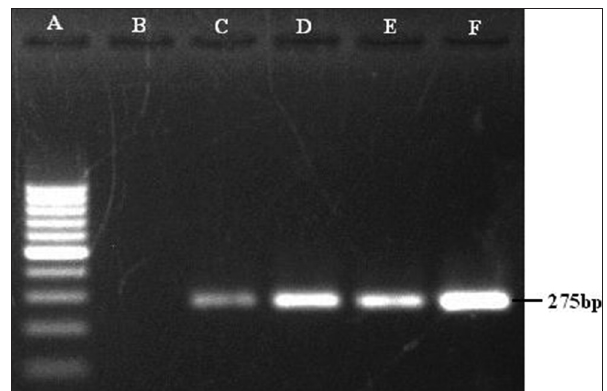
Figure-7: Polymerase chain reaction for the detection of pfhA gene (275 bp) of Pasteurella multocida. Lane A: 100 bp DNA Ladder, Lane B: Samples negative for pfhA gene, Lane C to F: Samples positive for pfhA gene.